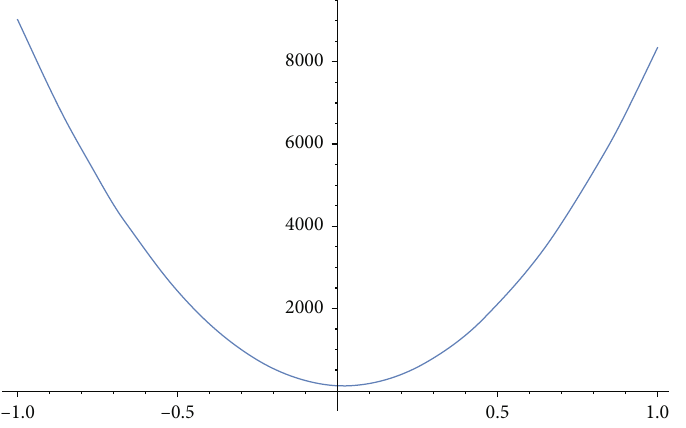
ð u , v Þ , β ð u , v Þ and the Gaussian curvature κ 0 0